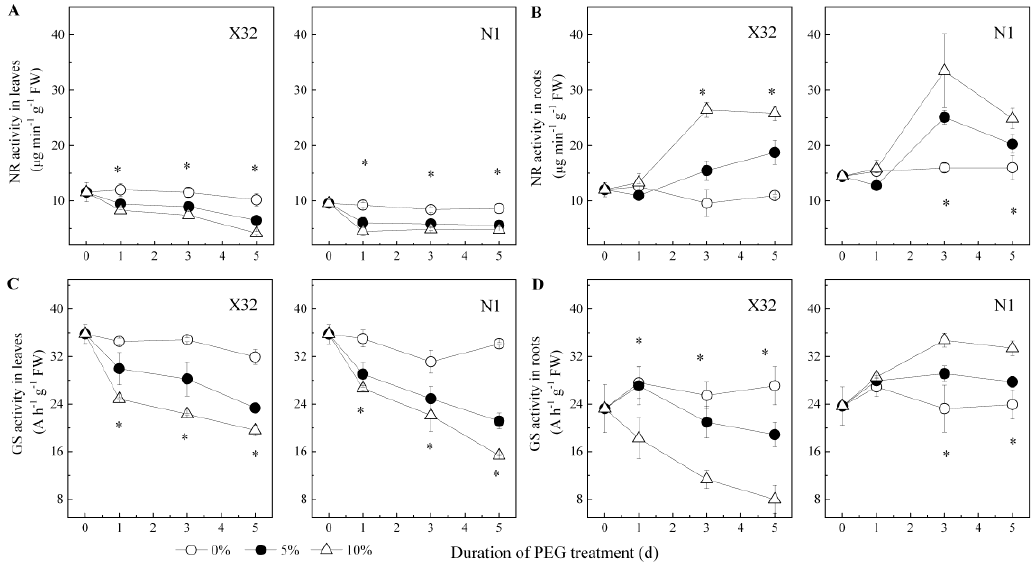
Figure 11. E ff ects of drought stress on GOGAT activity and GDH activity in leaves ( A , C ) and roots ( B , D ) of the sweet potato. X32 and N1 represent Xushu 32 and Ningzishu 1, respectively. The stages labeled with an asterisk (*) indicate significant di ff erences ( p < 0.05) among the three PEG levels in the figure.